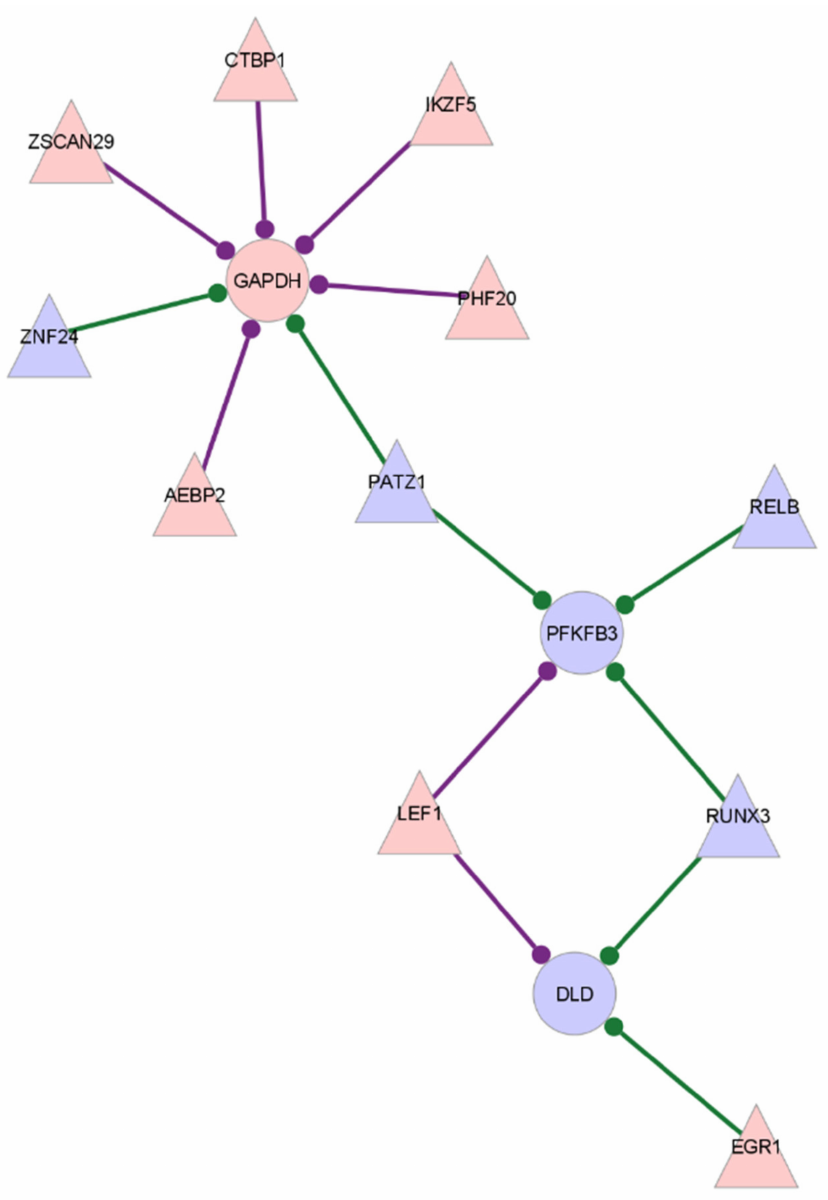
Figure 5. Subgraph of differentially expressed glycolysis-related enzymes with high degree centrality in the GeneHancer-annotated network of edges with significantly different edge weights between untreated RA and healthy control samples, in CD8 + Tem cells. The differentially expressed tran- scription factors that link to the enzymes are shown. Triangles indicate transcription factors and circles indicate target genes. Node colour shows the direction of differential expression: red nodes are over-expressed and blue nodes are under-expressed. The presence of an edge between a TF and a target gene refers to a significant difference in the edge weights of that gene pair between untreated RA samples and healthy samples. Purple edges show higher edge weight in RA, and green shows higher edge weight in healthy